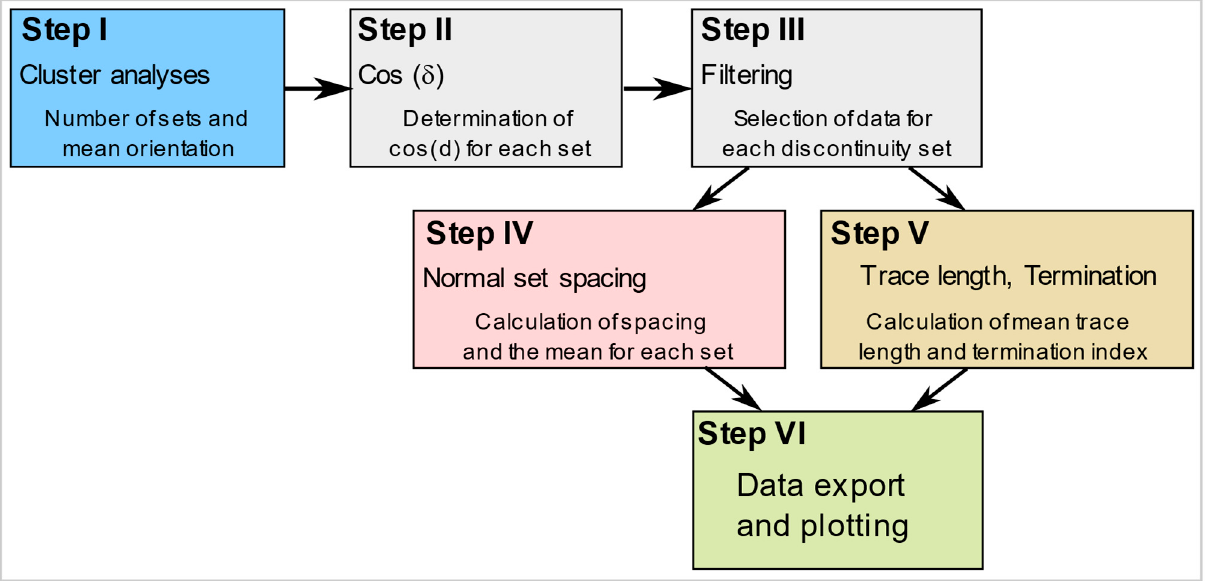
Figure 2. Workflow of the discontinuity analysis procedure, grouped into six